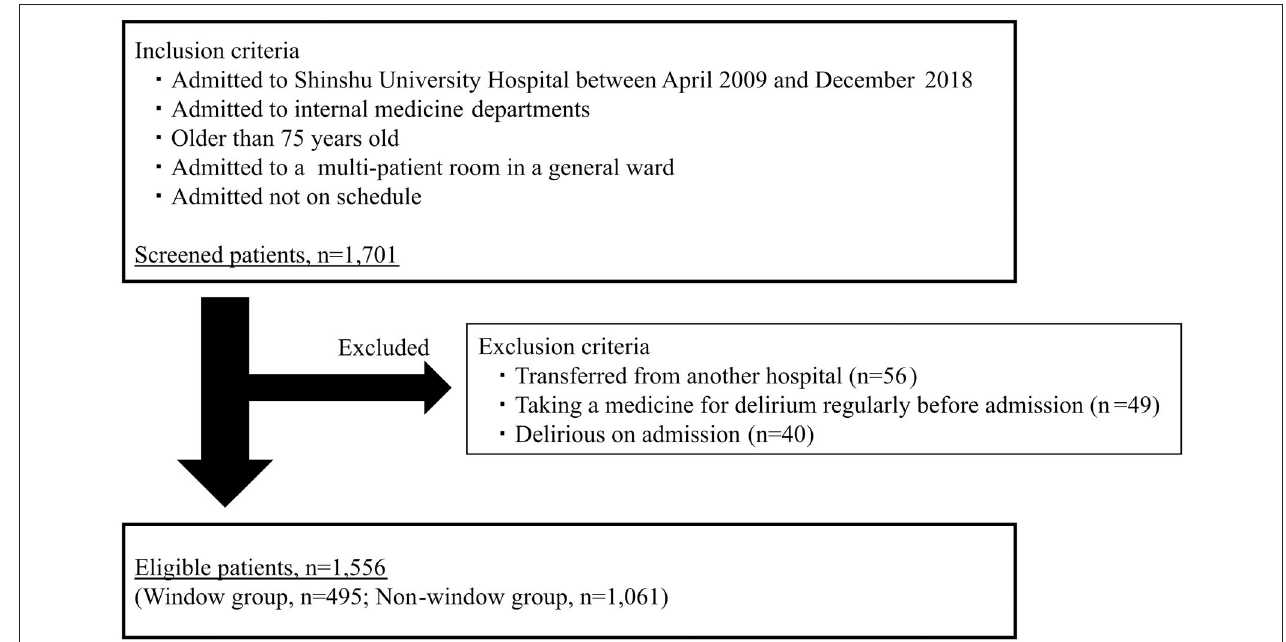
FIGURE 2 | Study flow chart. Inclusion and exclusion criteria of this study. The number of eligible patients was 1,556.